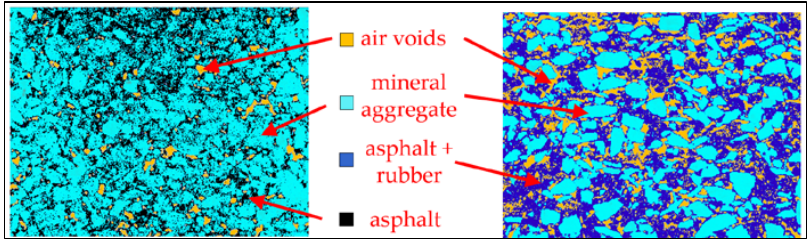
Figure 5. CT scan of the ordinary SMA 5 mixture ( a ) and poroelastic SEPOR-PSMA5 W4 ( b ).